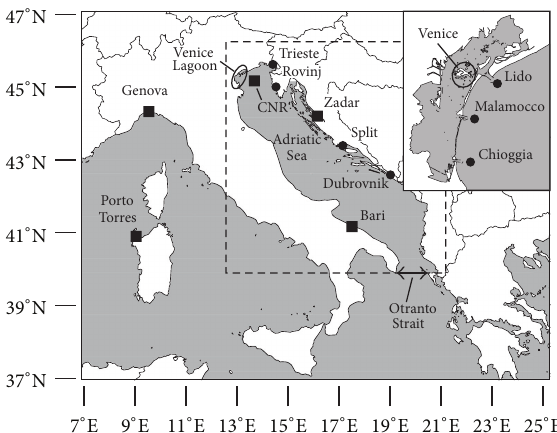
Figure 1: Latitude and longitude of Italy, the Adriatic Sea, and the Venice Lagoon are reported with the HYPSE domain. The locations of the tide and pressure gauges used in this study are also shown: the three inlet-gates of the Venice Lagoon, Trieste, Rovinj, Split, and Dubrovnik tide gauges and CNR platform, Genova, Porto Torres, Zadar, and Bari pressure